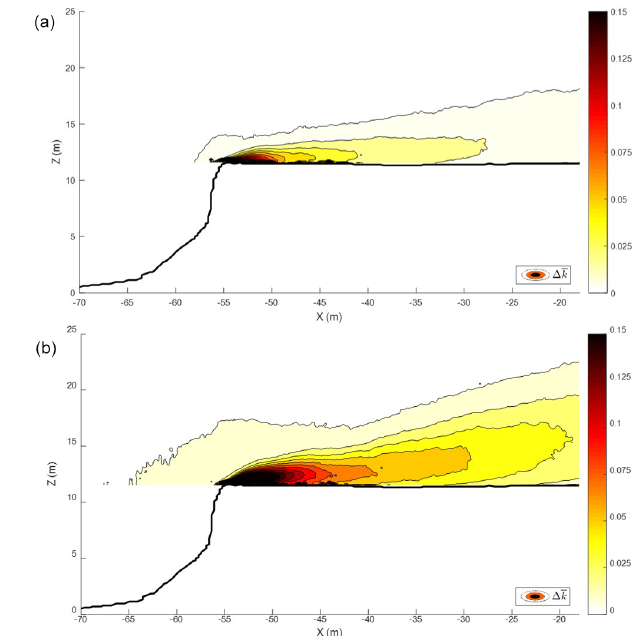
Figure 14. Contours of mean TKE increment (cid:49)k for (a) U14RC1 and (b)